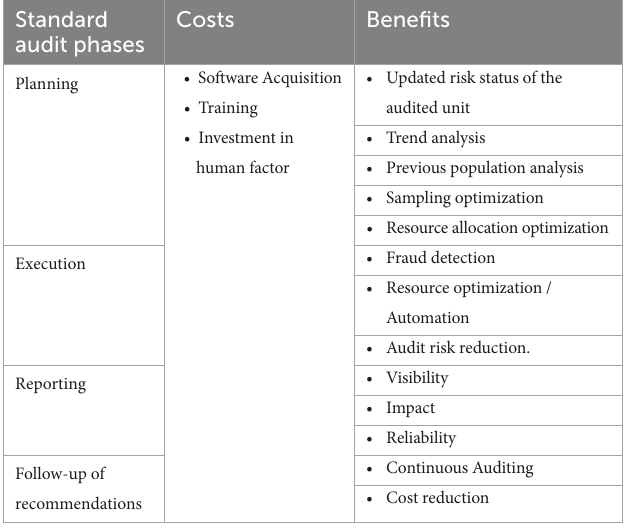
TABLE 3 Estimated percentage of time dedicated to each phase of a standard audit. Phase